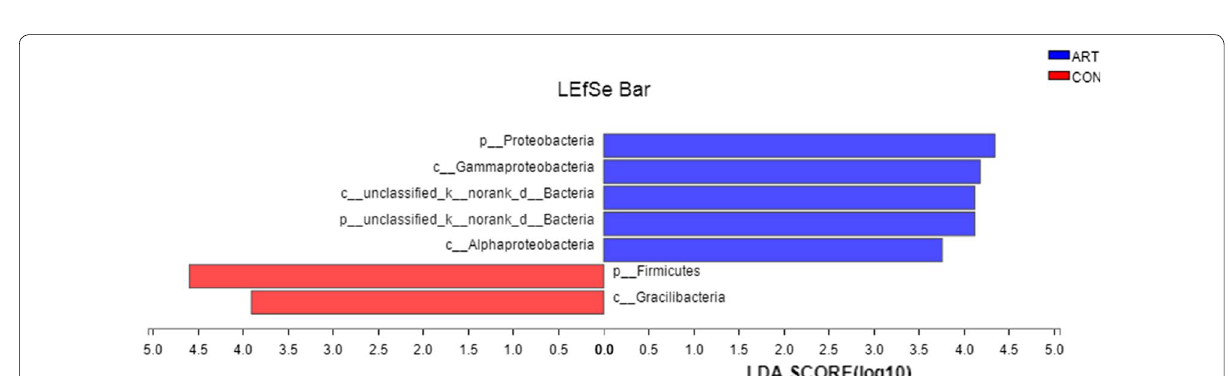
Fig. 3 LEfSe analysis revealing significant differences in species between the ART and CON groups, with Linear discriminant analysis (LDA) scores > 3.5 and P value <